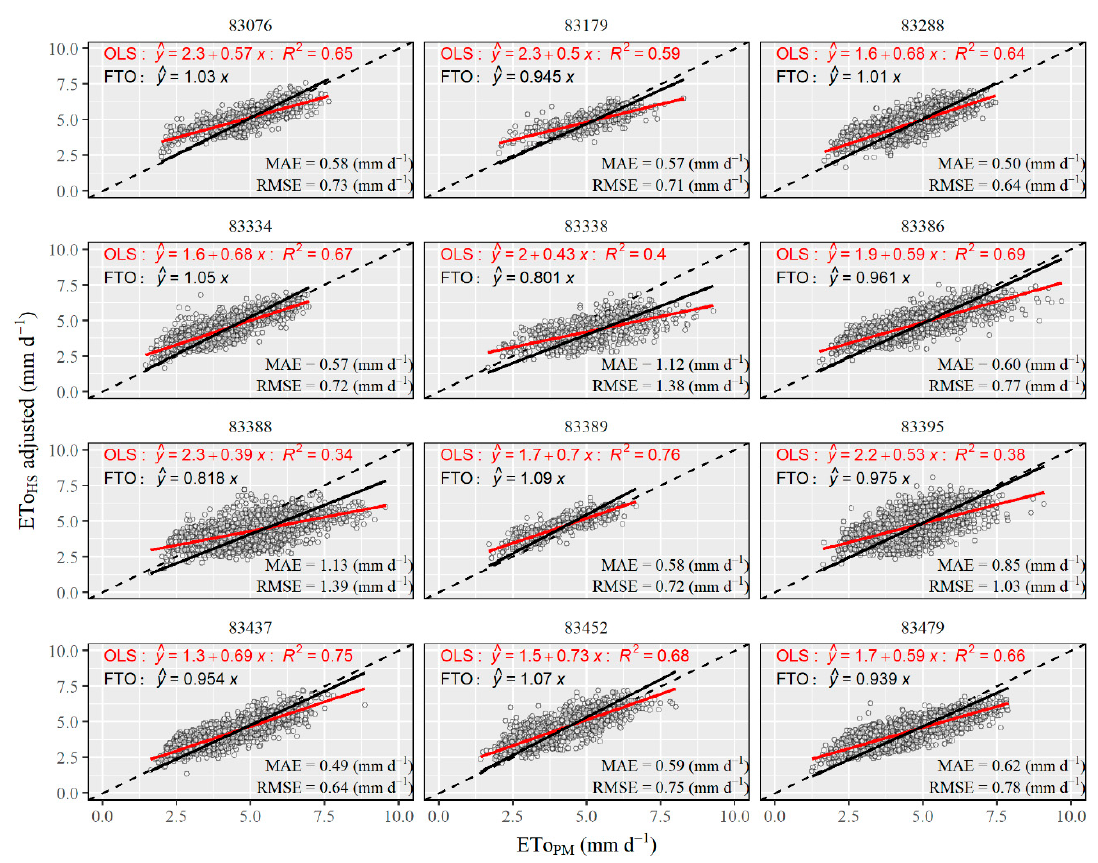
Figure 7. Daily reference evapotranspiration scatterplots between Penman–Monteith and Hargreaves–Samani improved by fitting new coefficients (approach A1). The red and black lines are the ordinary least squares (OLS) and forced to the origin (FTO) regressions.